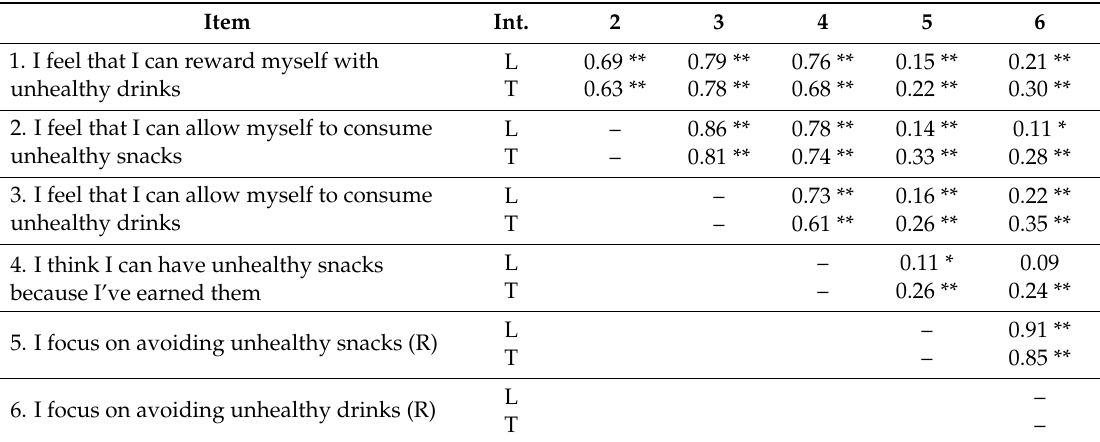
Table 2. Correlation matrix between ESLS items for light ( n = 410) and tiring ( n = 610) physical activity versions of the